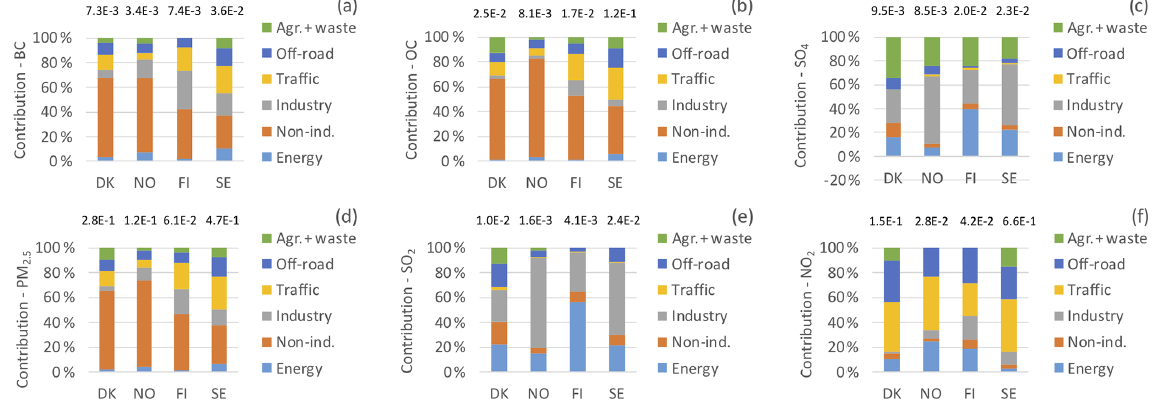
pact of O 3 titration by local fresh NO emissions. Danish